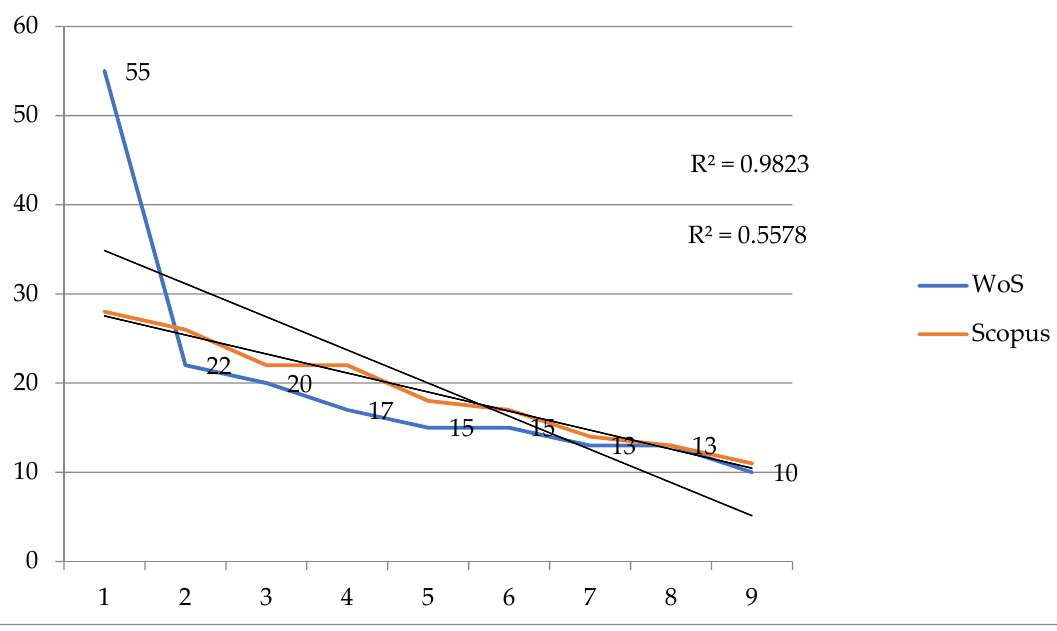
Figure 6. Dispersion of the scientific production indexed in the Web of Science and Scopus databases.